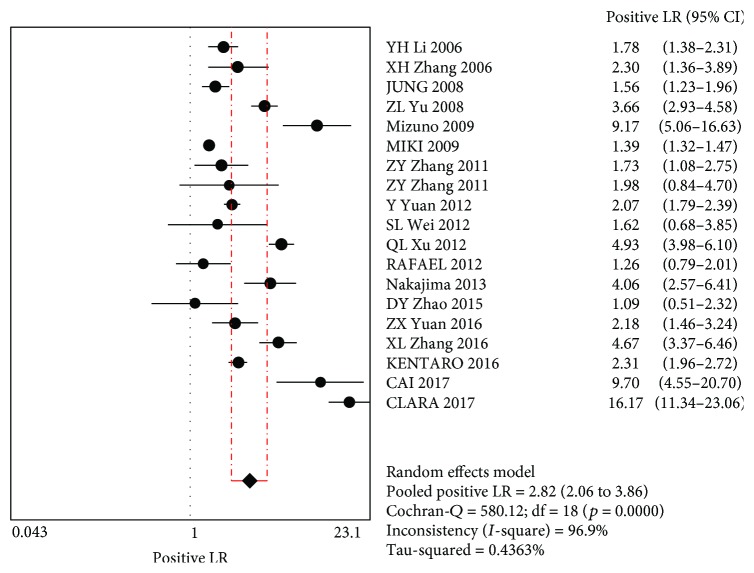
Merging positive likelihood ratios.